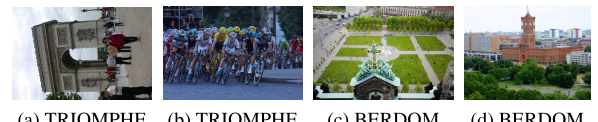
Table 2. The dataset dependent threshold q min is listed for each dataset. Based on this threshold a different number of clusters having more than 100 images are created. For each dataset the size of the different clusters is